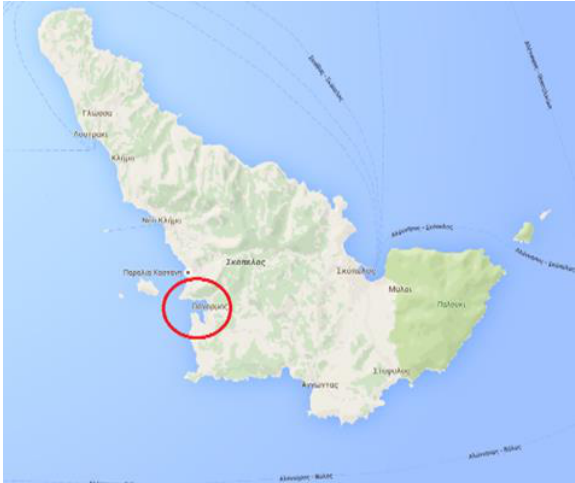
Figure 2. Area of case study. Adrina beach, Panormos, in Skopelos, Greece. © Google Maps